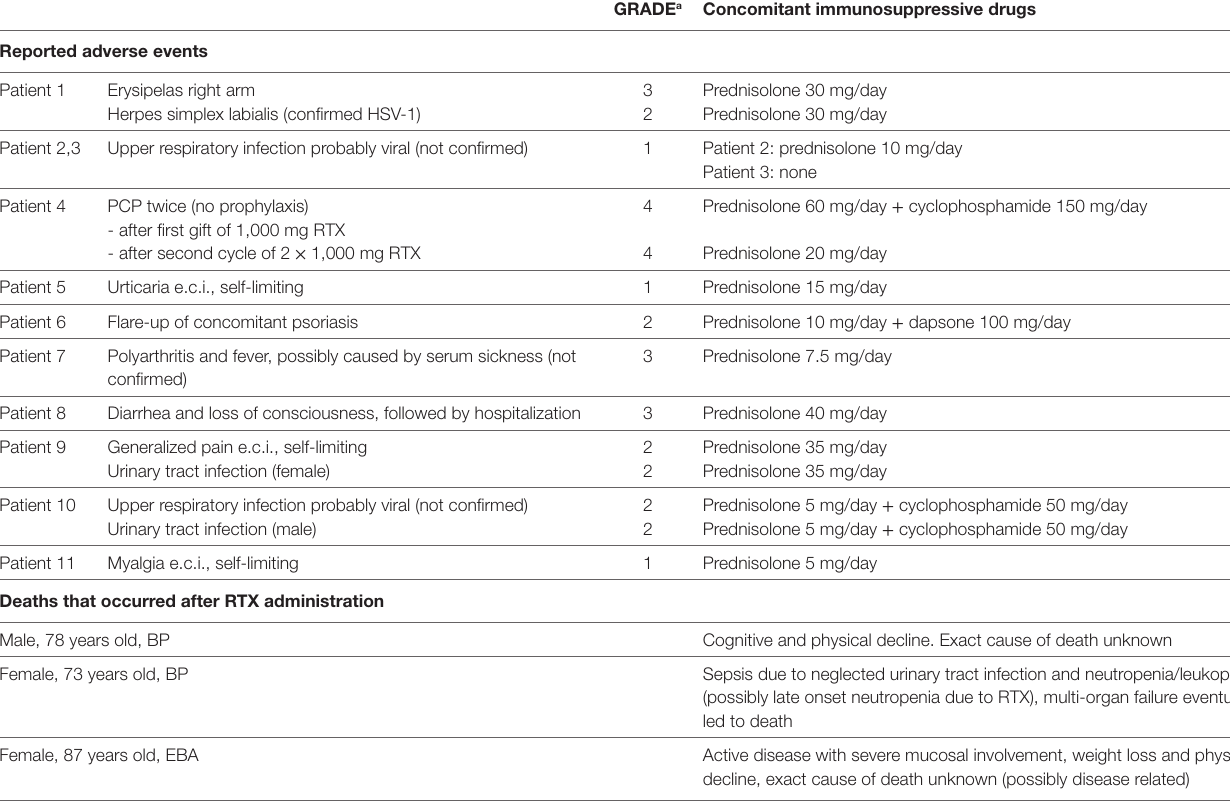
Table 2 | Adverse events and deaths reported in pemphigoid patients treated with rituximab